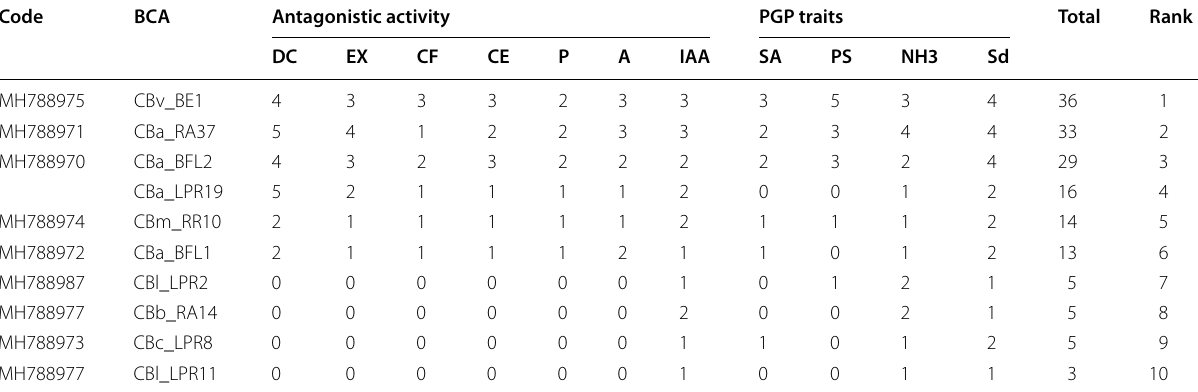
Table 4 General ranking of endophytic bacteria based on their antagonist properties against Ralstonia solanacearum and their plant growth-promoting traits